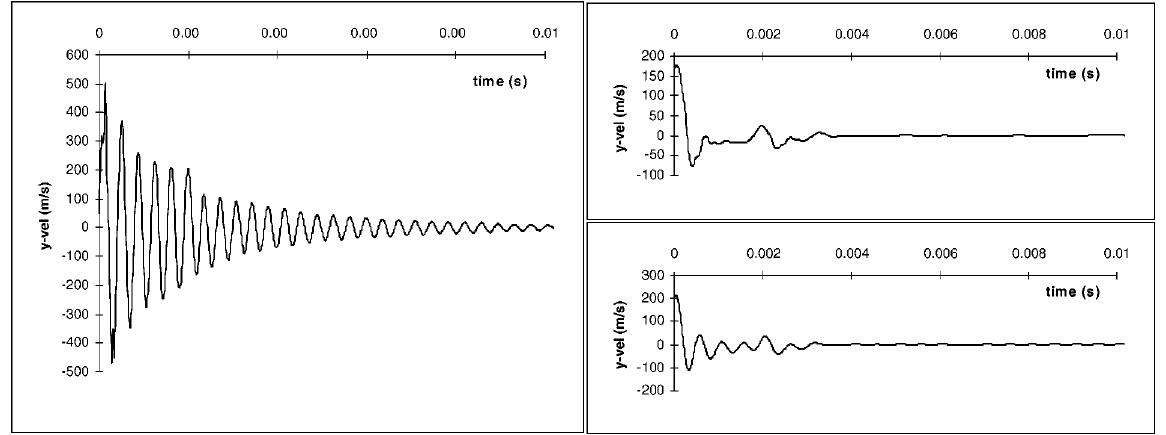
Fig. 5. Field test result (left) and when filtered: wavelet (top, right) and Fourier (bottom,